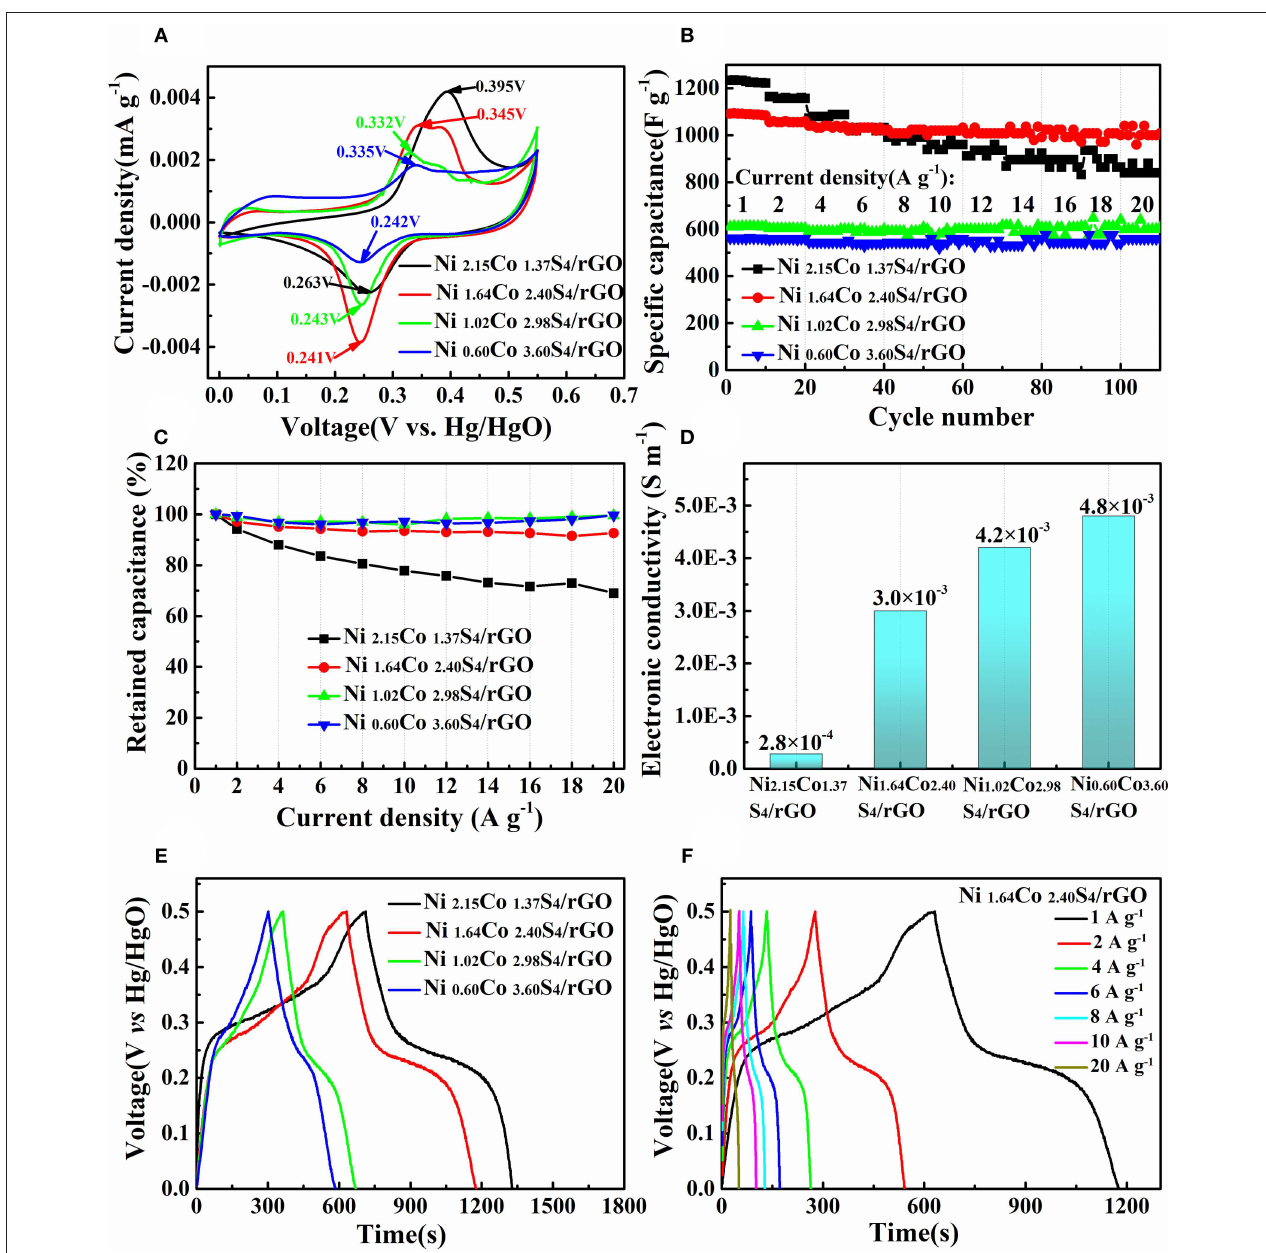
FIGURE 5 | CV curves of Ni x Co y S 4 /rGO composites at the scan rate of 1mV s − 1 (A) ; rate performance of Ni x Co y S 4 /rGO composites at various current densities from 1A g − 1 to 20A g − 1 (B) ; capacitance retention of Ni x Co y S 4 /rGO composites with the increase of current density (C) ; electronic conductivity of Ni x Co y S 4 /rGO composites (D) ; GCD curves of different composites at the current densities of 1A g − 1 (E) ; GCD curves of Ni 1.64 Co 2.40 S 4 /rGO at various current densities from 1A g − 1 to 20A g − 1 (F)